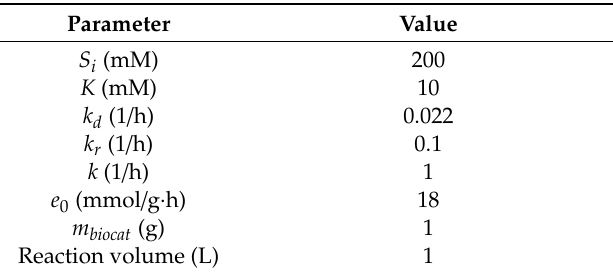
Table 1. Data used to simulate system behavior.